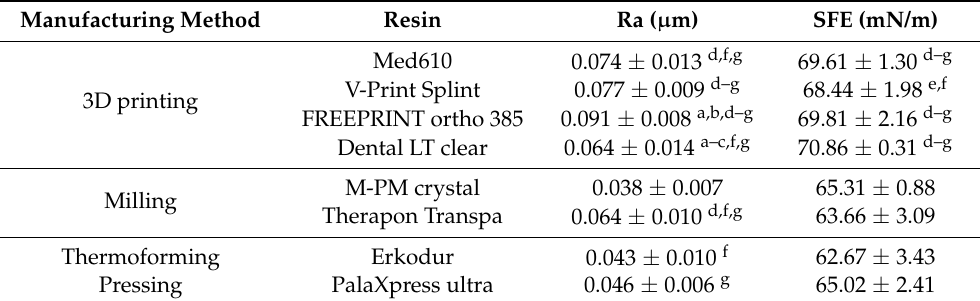
Table 2. Surface characteristics after surface treatment. Data are expressed as means and standard deviations; SFE = surface free